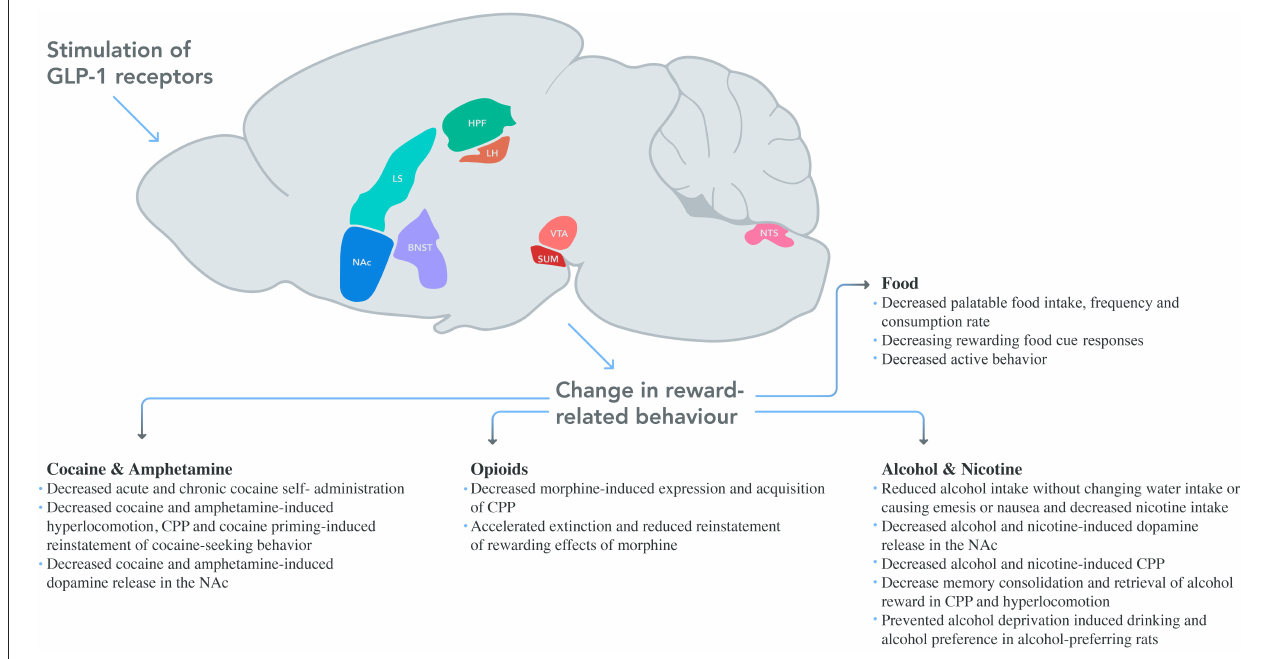
FIGURE 2 | Schematic drawing of reversed reward responses after GLP-1 modulation. In addition to the systematic injection of GLP-1 agonists’ effects on the brain; LH, VTA, NAc, NTS, SUM, and LS were studied for palatable food, whereas VTA, NAc, and NTE were studied for alcohol, NAc was studied for amphetamine, NAc and LS were for cocaine and NTS was for nicotine use behavior. Areas were drawn based on Allen Mouse Brain Atlas (NAc, nucleus accumbens; LS, lateral septum; HPF, hippocampal formation; LH, lateral hypothalamus; VTA, ventral tegmental area; SUM, supramammillary nucleus; NTS, nucleus tractus solitarius; BNST, bed nucleus of the stria